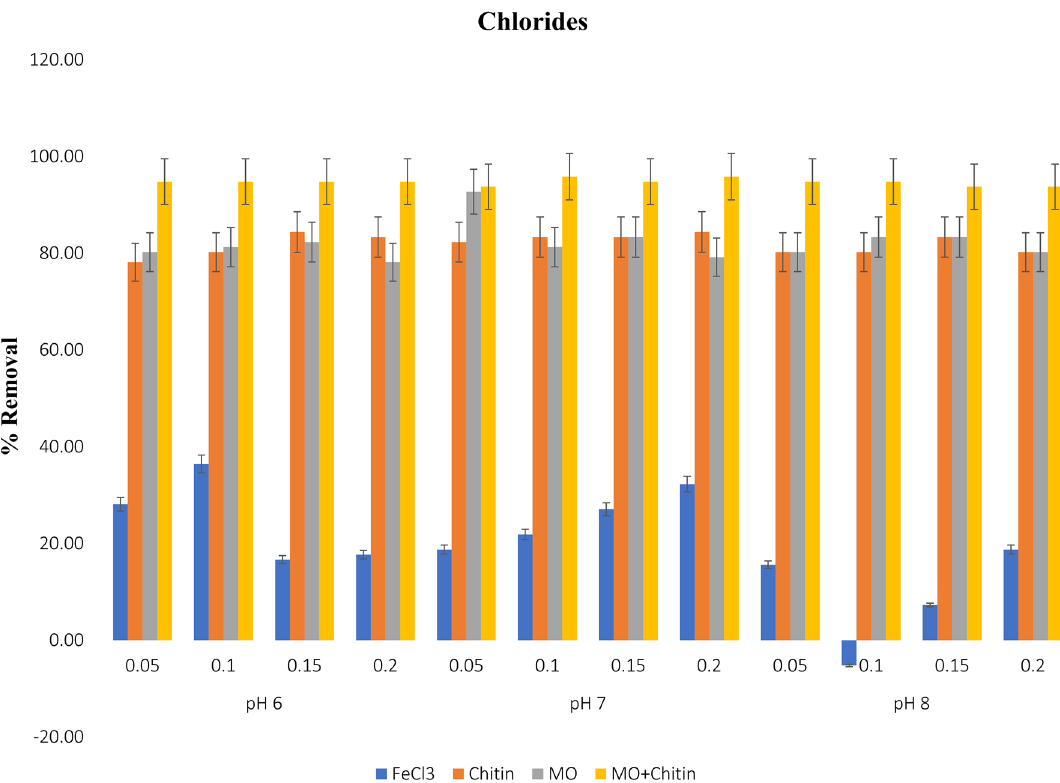
Fig. 4 Chloride reduction by the